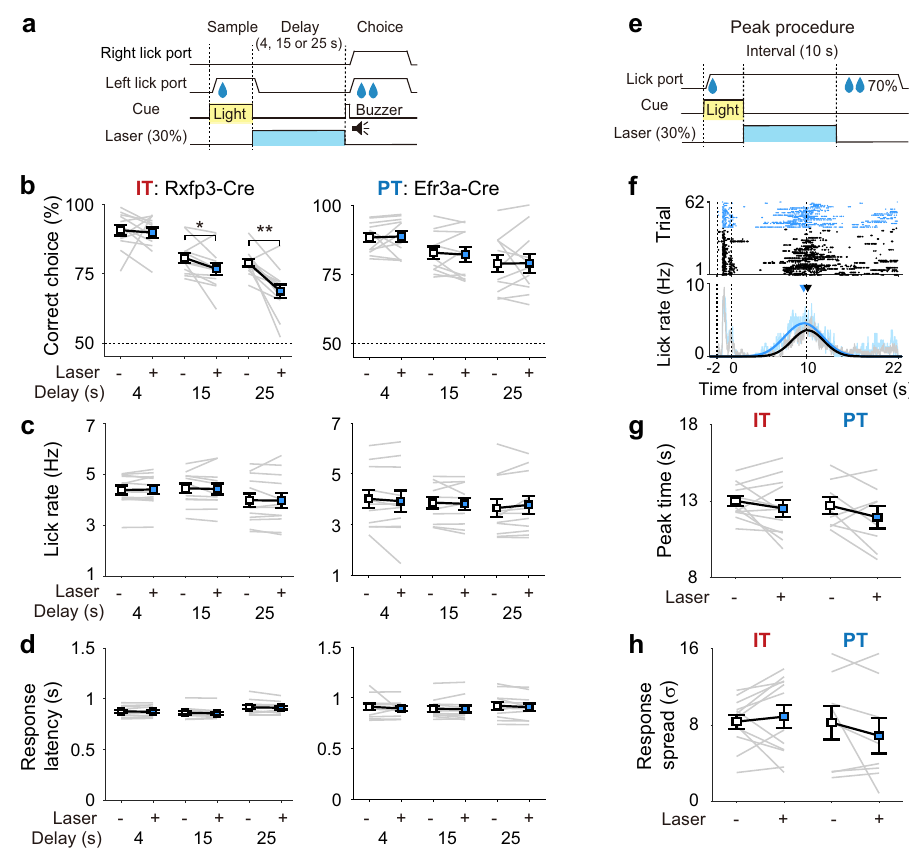
Fig. 8 Inactivation of IT neurons impairs working memory. a Schematic for optogenetic inactivation. Laser was given throughout the delay period (blue bar; 4, 15, or 25 s) in a randomly chosen 30% of trials. b Behavioral performance in the absence ( − ) or presence ( + ) of laser stimulation for different delay durations (4, 15, and 25 s). * p < 0.05; ** p < 0.01 (two-way repeated measures ANOVA followed by Bonferroni ’ s post hoc tests). c Lick rate. d Response latency (the latency to the fi rst lick since delay offset). e Schematic for optogenetic inactivation in the peak procedure. f An example peak procedure session. Only omission trials are shown. Lick raster plots (upper) and lick histograms (bottom) with (blue) or without (gray) laser stimulation are shown. Peak time and SD of the lick response were determined by fi tting a Gaussian curve to each lick histogram (thick curves). g , h Group data. Peak time ( g ) and SD ( h ) of Gaussian- fi tted lick responses during omission trials with ( + ) or without ( − ) laser stimulation. Gray lines, individual animals; Squares and error bars, mean and SEM across animals ( n = 12 Rxfp3-Cre and 11 Efr3a-Cre